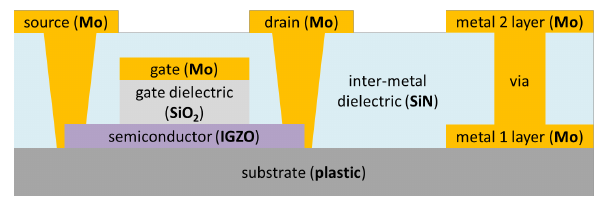
Figure 2: Cross-section of a unipolar oxide n-TFT on a plastic